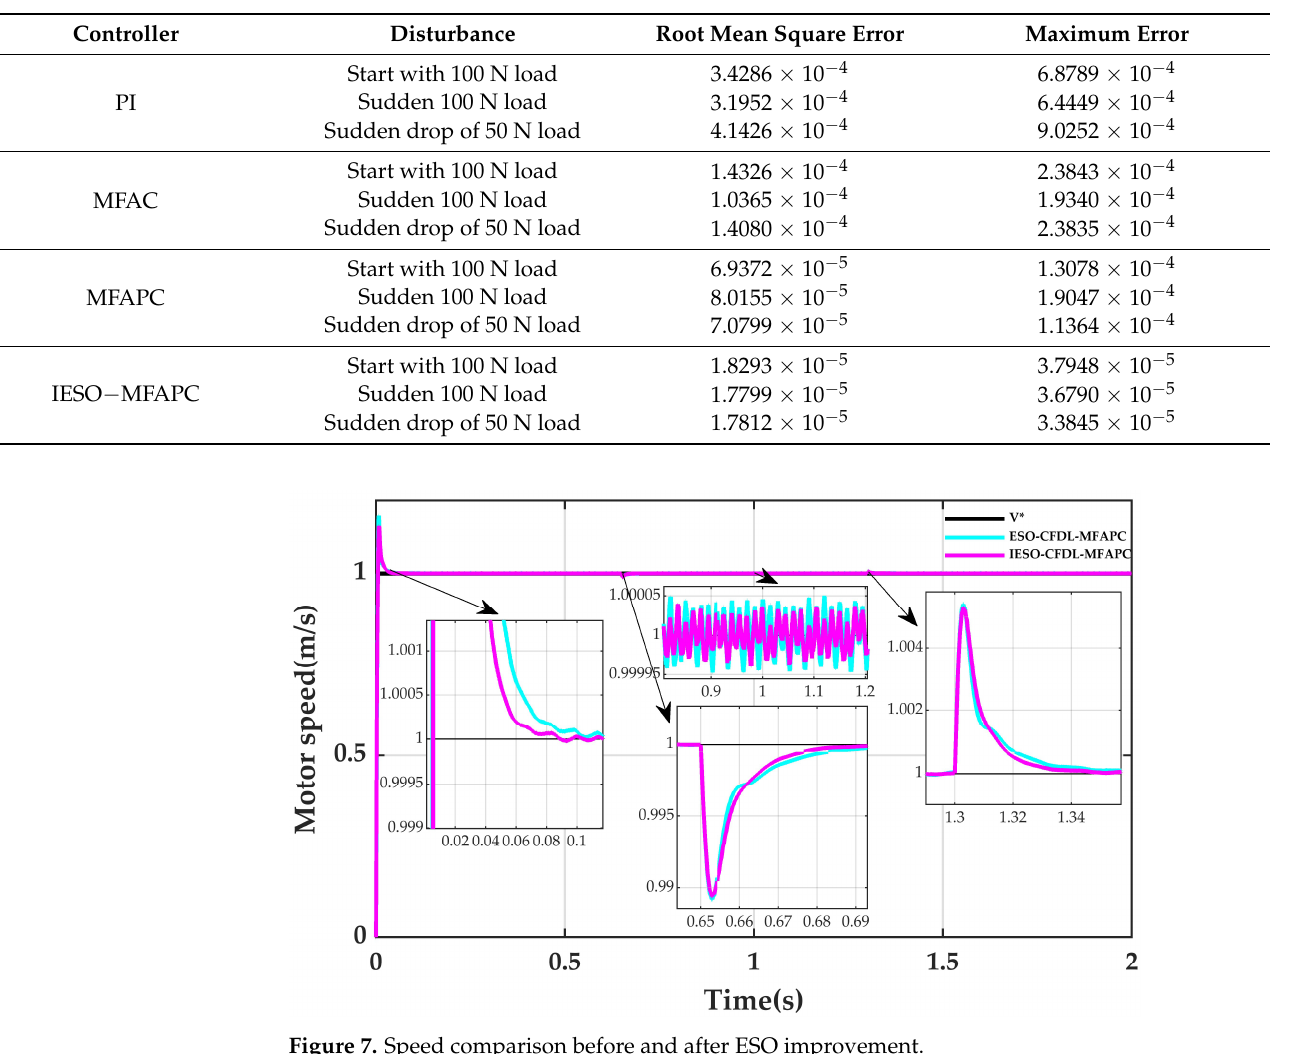
Table 4. Quantitative index of four algorithms when the load changes.